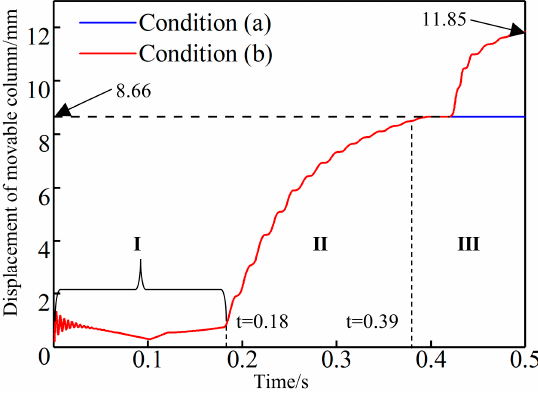
Figure 13. Displacement curve of the movable column.